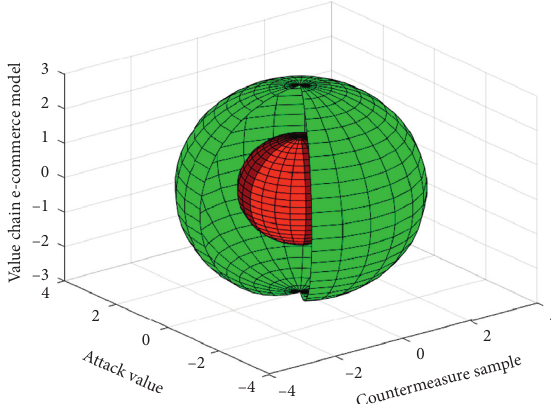
Figure 6: Targeted confrontation sample attack value chain e-commerce Table 3: Algorithm enhances the objective evaluation data of the value chain e-commerce model. Test value chain